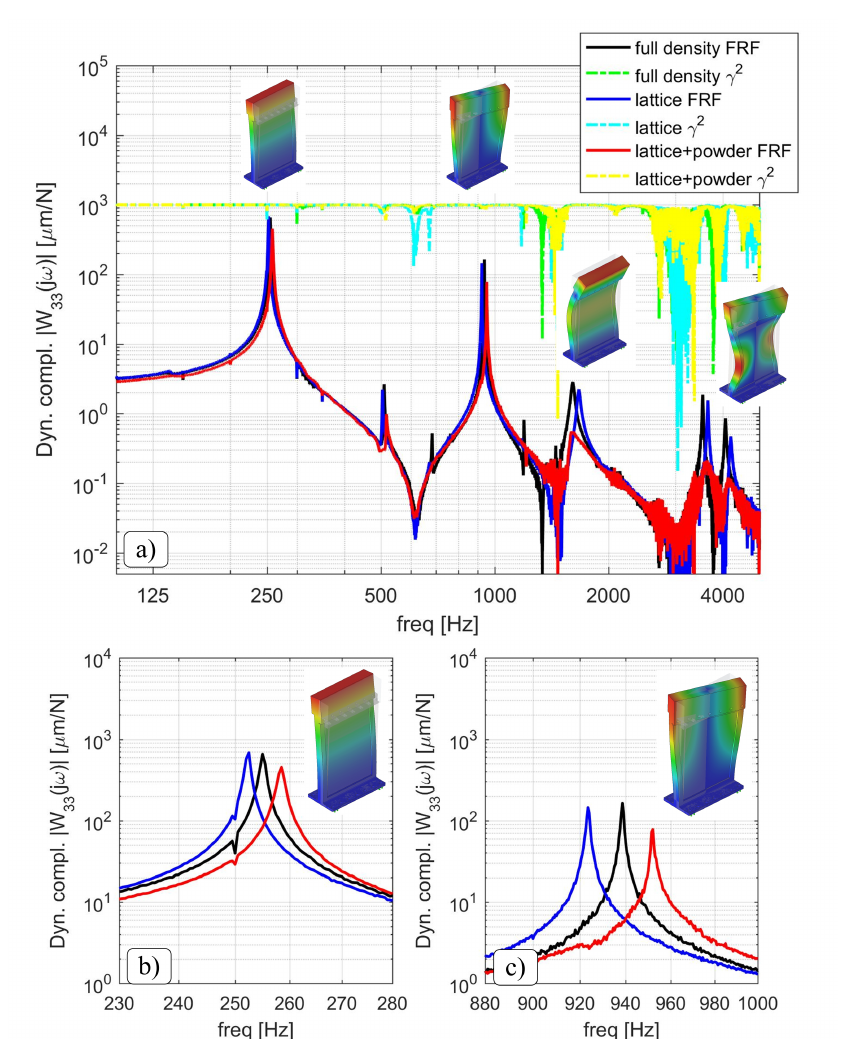
Figure 11. Blade dynamic compliance inspected at node 3. The lower resonance peaks of the blade embedding lattice structures and powder are visible in the enlarged views in the bottom of the